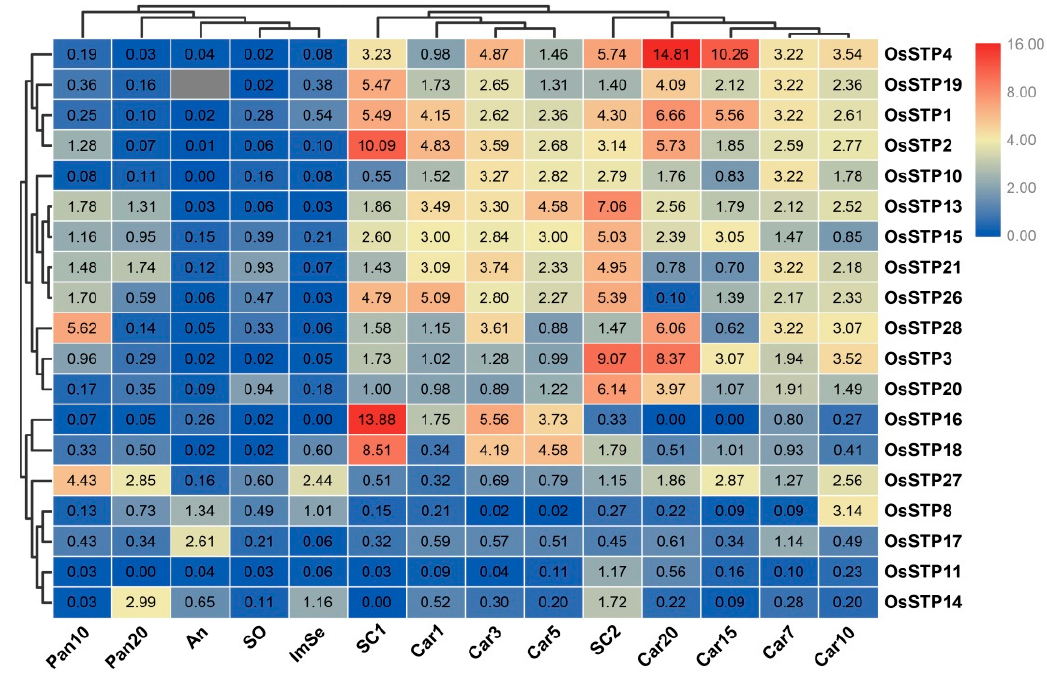
Figure 4. Expression profiles of the rice STP genes in 14 different tissues by qRT-PCR. Pan10/20 (panicles harvested before heading at lengths of 10/20 cm), SC1/2 (seed coat, 3/15 days after flowering), An (anther, 1 to 3 days before flowering), SO (stigma and ovary, 1 to 3 days before flowering), ImSe (immature endosperm, 15 days after flowering), and Car1/3/5/7/10/15/20 (caryopses, 1/3/5/7/10/15/20 days after flowering) [31]. The color scale represents relative expression levels from the 2 −ΔΔ CT method: red indicates a high level and green represents a low level of transcript abundance.